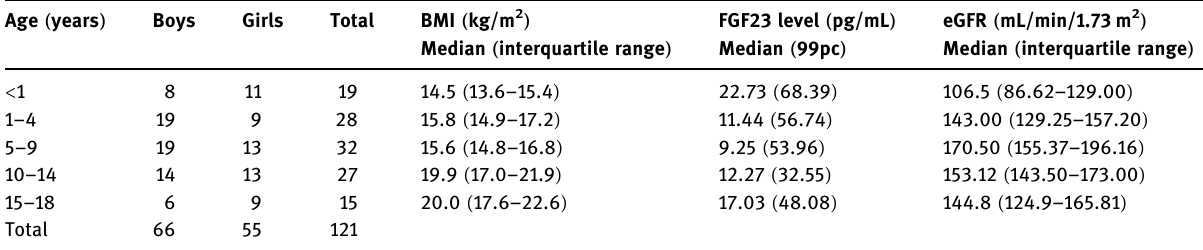
Table 1: Sex distribution, BMI, serum FGF23 level and eGFR in the age groups Age ( years )